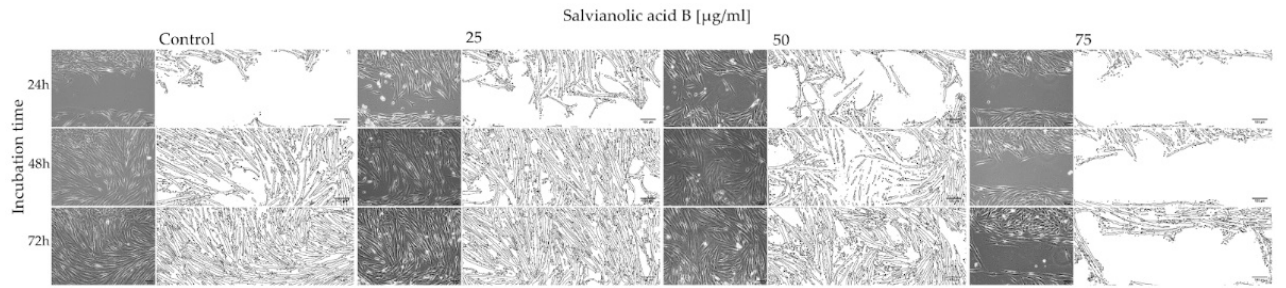
Figure 3. Microscopy studies and visualizations of salvianolic acid B-untreated and -treated fibro- blasts.